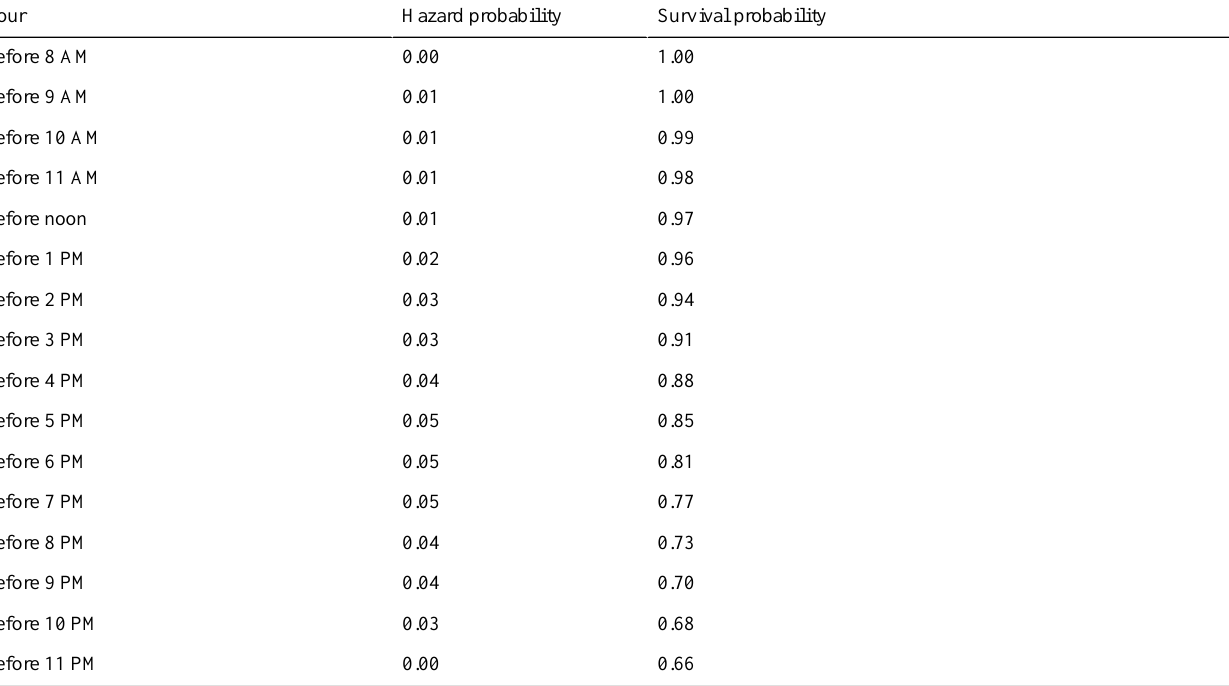
Table 6. Hazard and survival probabilities of time of average moderate-to-vigorous physical activity accumulation.